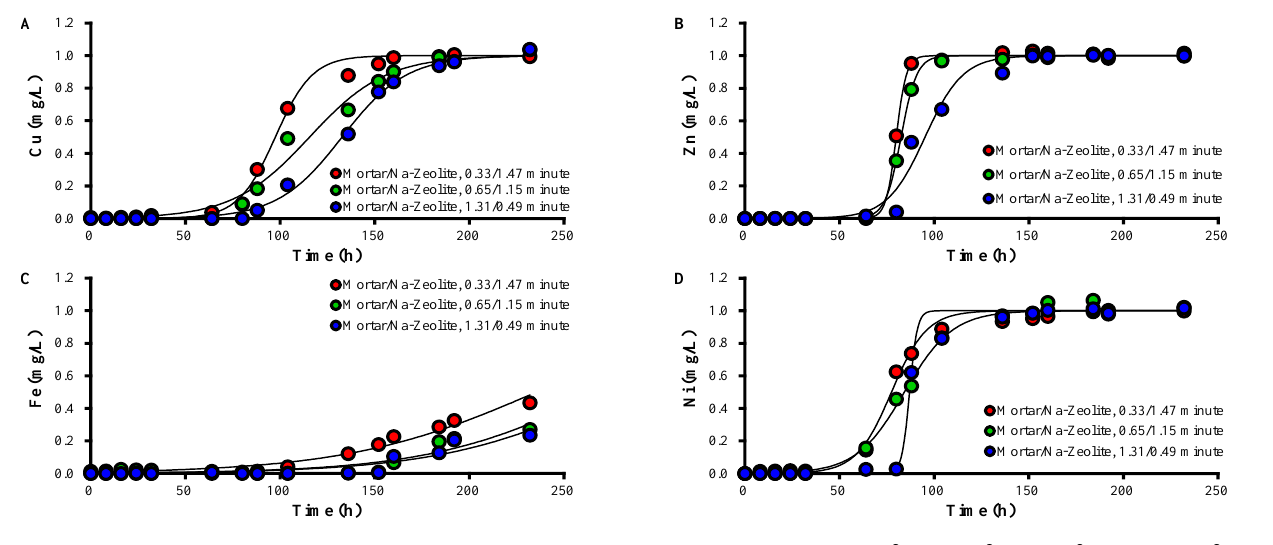
Figure 5. Variations over time in the concentrations of ( A ) Cu 2+ , ( B ) Zn 2+ , ( C ) Fe 3+ , and ( D ) Ni 2+ ions in the effluent collected after the Na-zeolite layer from the dual system, in mg/L, for different ratios of EBCTs; the working temperature is 20.5 °C. Table 7. Adsorption constants for heavy metals collected from the mortar/Na-zeolite dual